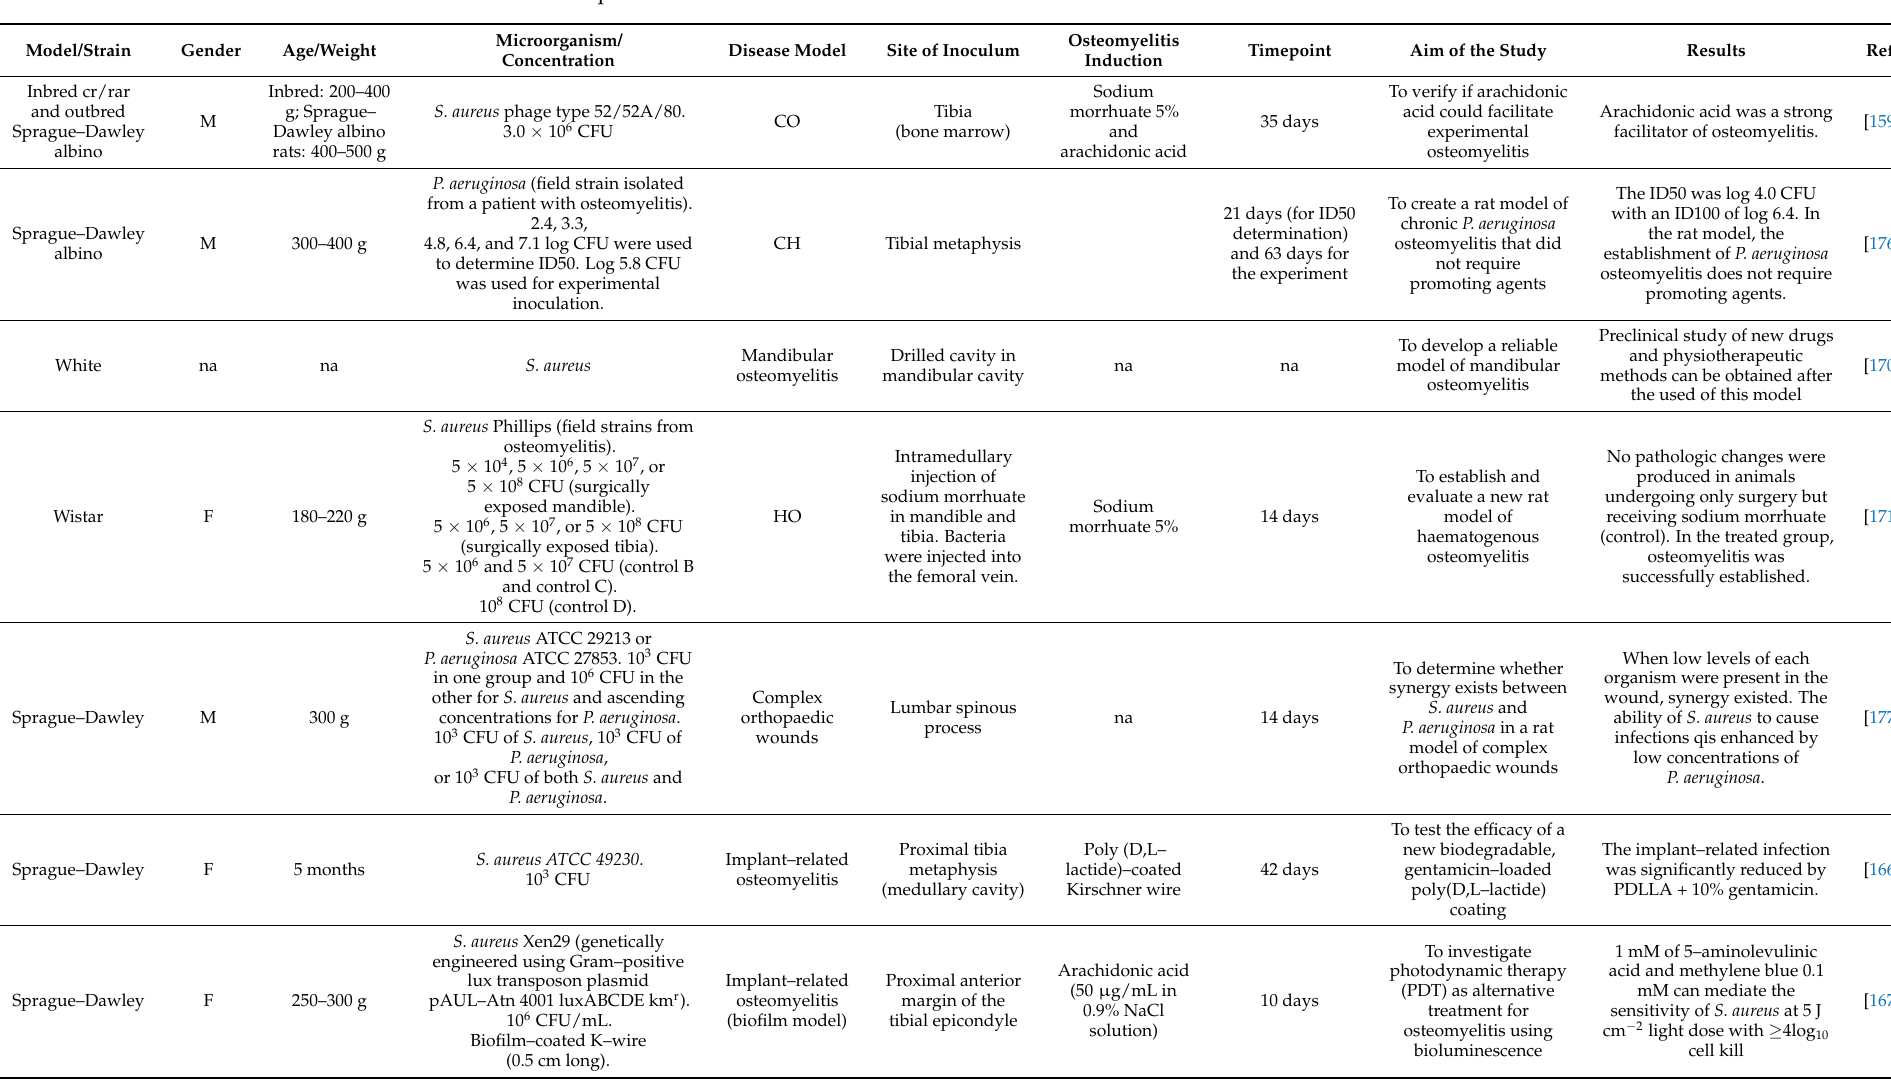
Table 2. Rat models of orthopedic